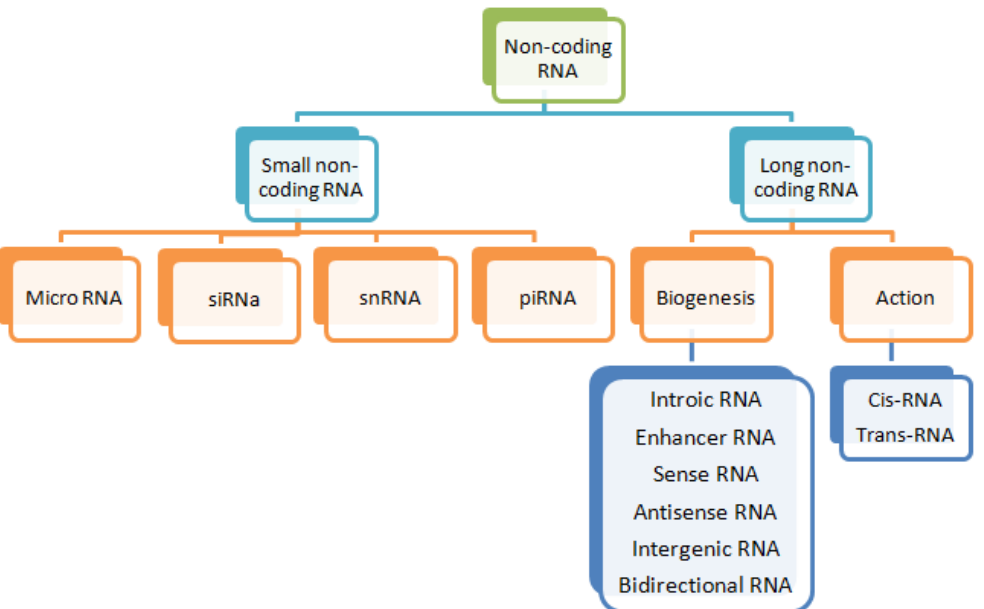
Figure 1. Classification of non-coding RNA. Non-coding RNA can be divided into two groups (small and long non-coding RNA) based on their size. Small non-coding RNA can be further divided into miRNA, piRNA, siRNA, etc. Long non-coding RNA can be subdivided into sense, anti-sense, intronic, intergenic, cis-, and trans-RNA based on their biogenesis and mechanism of action (modified from Dahariya et al. [8]).